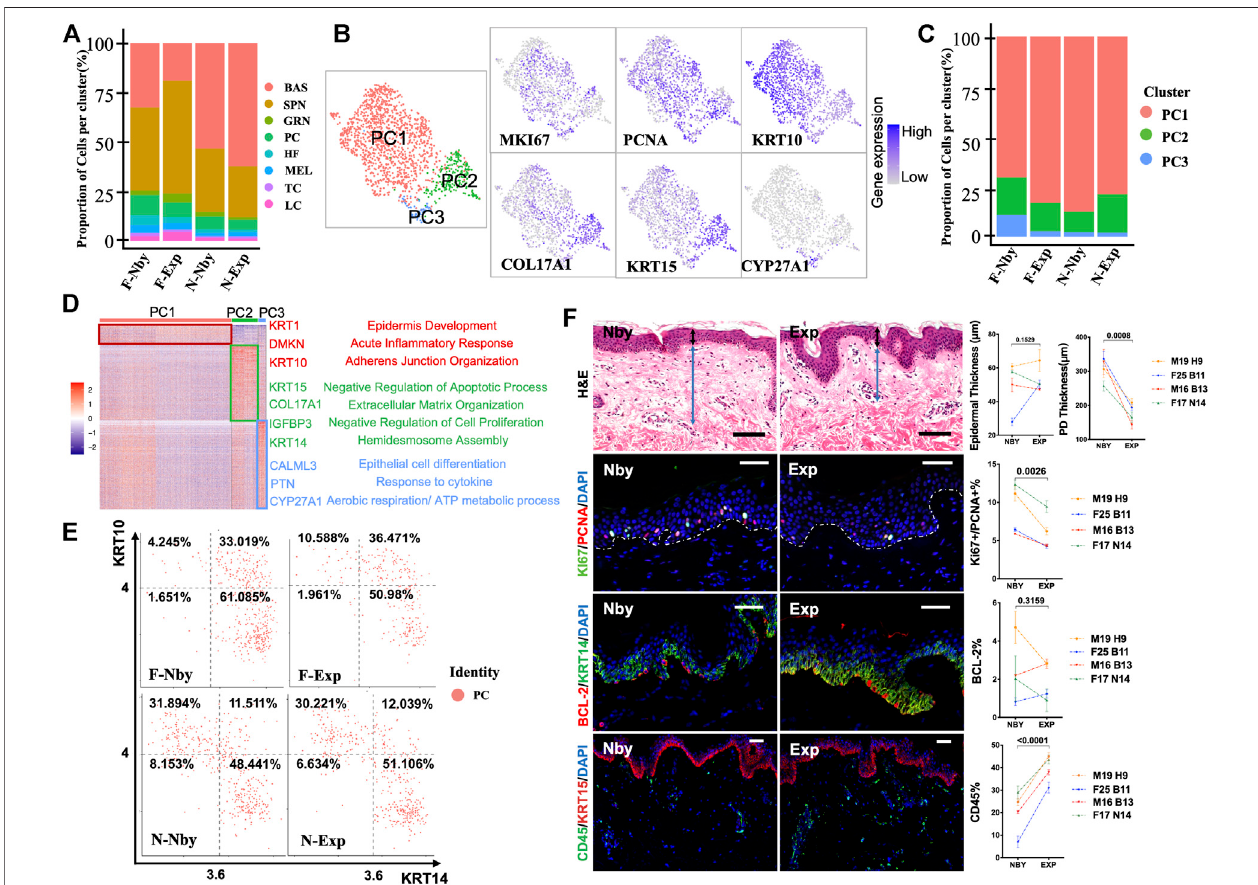
FIGURE 3 | LTE-induced decayed proliferative activities of the epidermis. (A) The proportion of cells for each of the eight cell types in each sample. Note the decreased fraction of the PC cell. (B) UMAP plots showing the subpopulations of proliferative cells (PC) with the expression of representative genes are shown to the right. (C) Theproportionoftheproliferativesubpopulationsineachsample.Notetheinconsistentchangesintheproportionbetweenthesamples. (D) Heatmapshowing the scaled expression levels of genes highly expressed speci fi cally in PC1, PC2, and PC3. The color key from blue to red indicates low to high gene expression levels. Cell-type-speci fi c representative genes and GO terms are listed to the right. (E) Two-dimensional scatter plots of KRT14 and KRT10 expression in PC. (F) Representative images of the nby and exp skin. The sections belong to four individuals undergoing long-term tissue expansion. Two-way ANOVA was applied